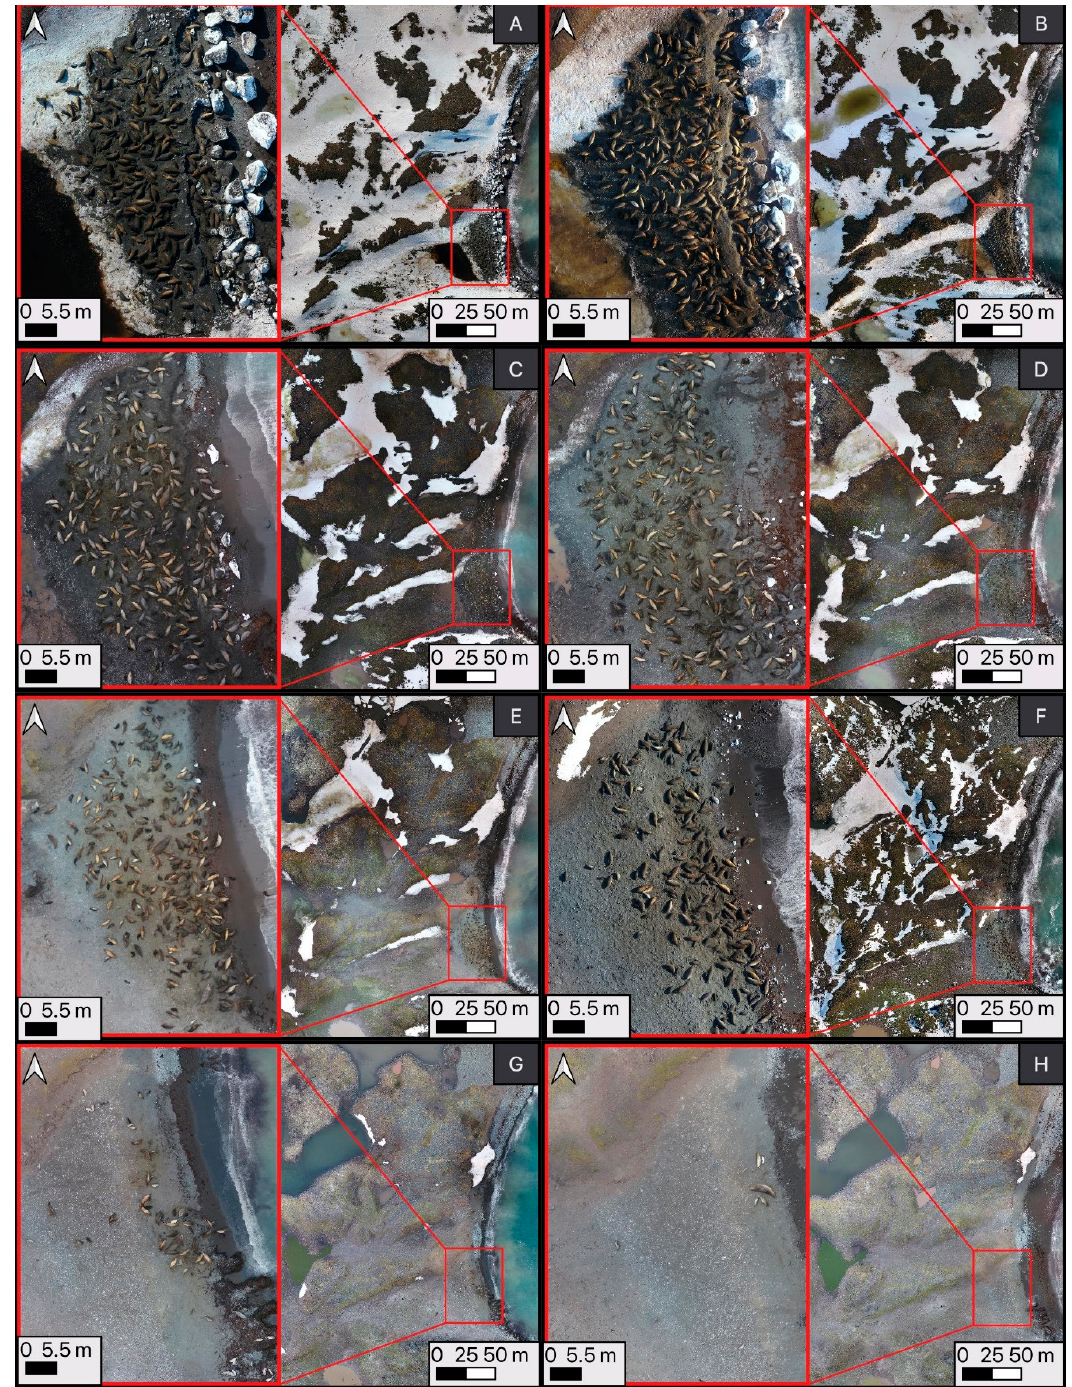
Figure 6. Aerial images of Patelnia Point with magnification of the main harem on ( A ) October 15; ( B ) October 19; ( C ) October 24; ( D ) October 27; ( E ) November 1; ( F ) November 7; ( G ) November 16; and ( H ) November 26.